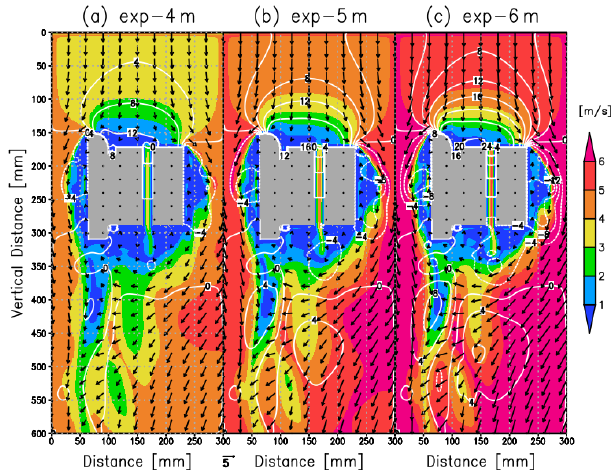
Figure 7. Cross section of the simulated flow speed around the CPS housing (absolute speed: ms − 1 ) assuming an ascending speed of (a) 4ms − 1 , (b) 5ms − 1 , and (c) 6ms − 1 . Contours and gray shades indicate the pressure difference from the initial state (Pa) and CPS housing.